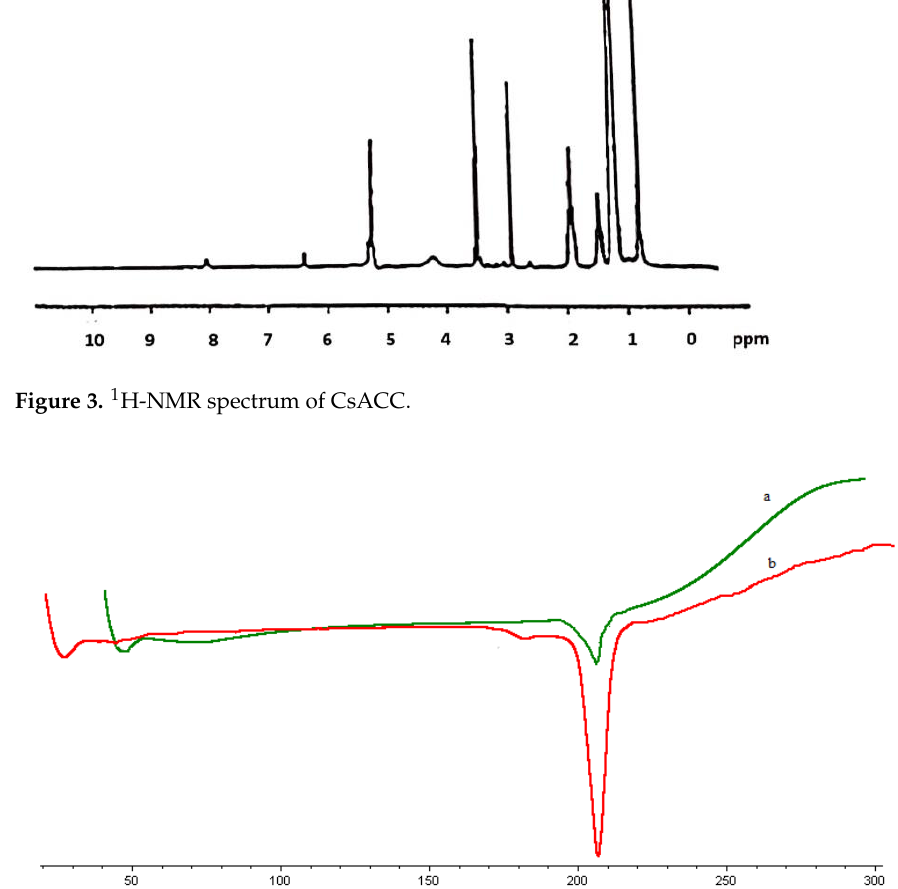
Figure 4. DSC curve of CsACC ( a ), CC ( b ).